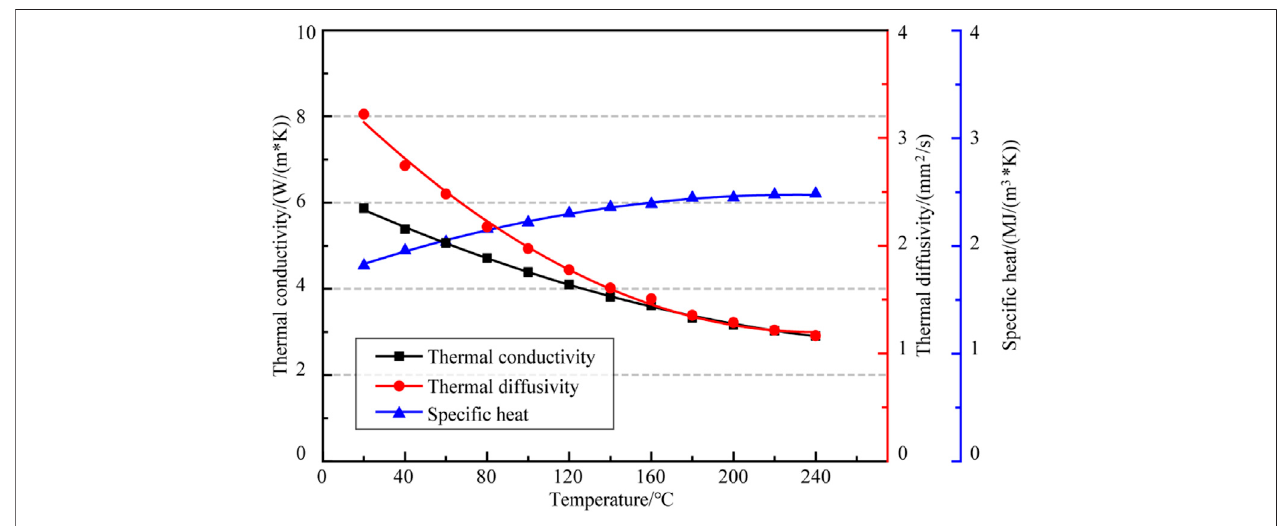
FIGURE 5 | Test results of thermal parameters of polycrystalline salt rock.